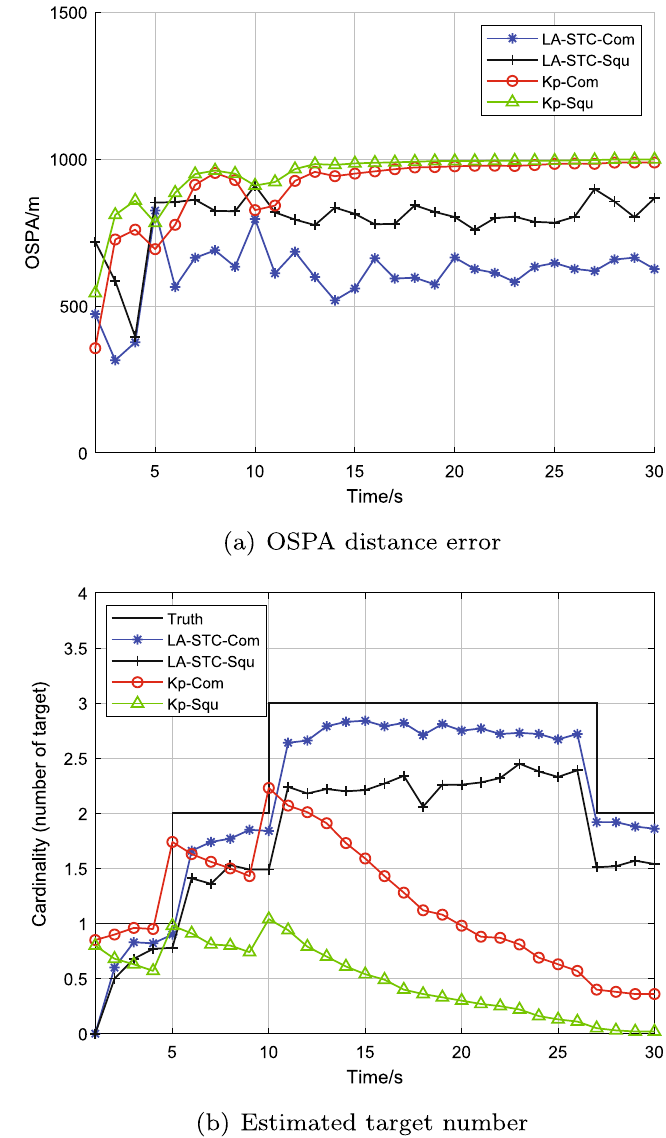
Fig. 7 Comparison of LABer-STC-TBD algorithm and KpBer-TBD algorithm under Swerling